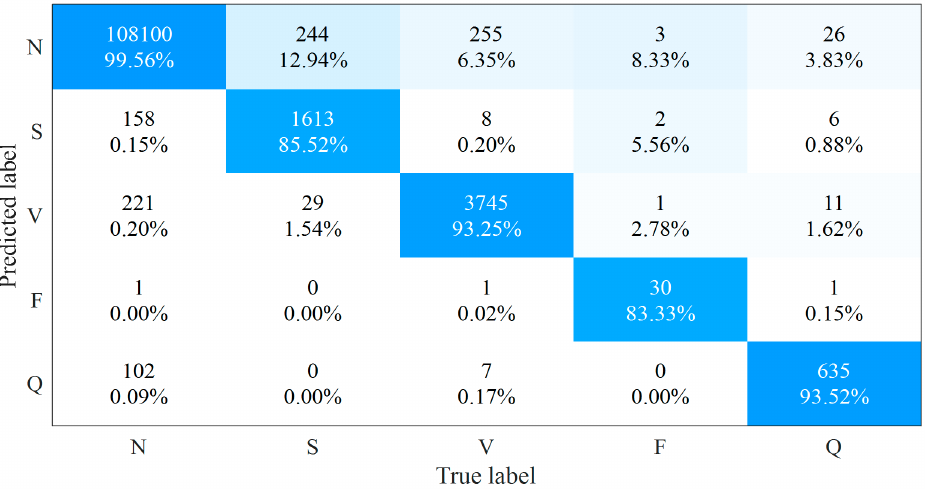
Figure 7. The confusion matrix of the proposed method on the CPPDB.